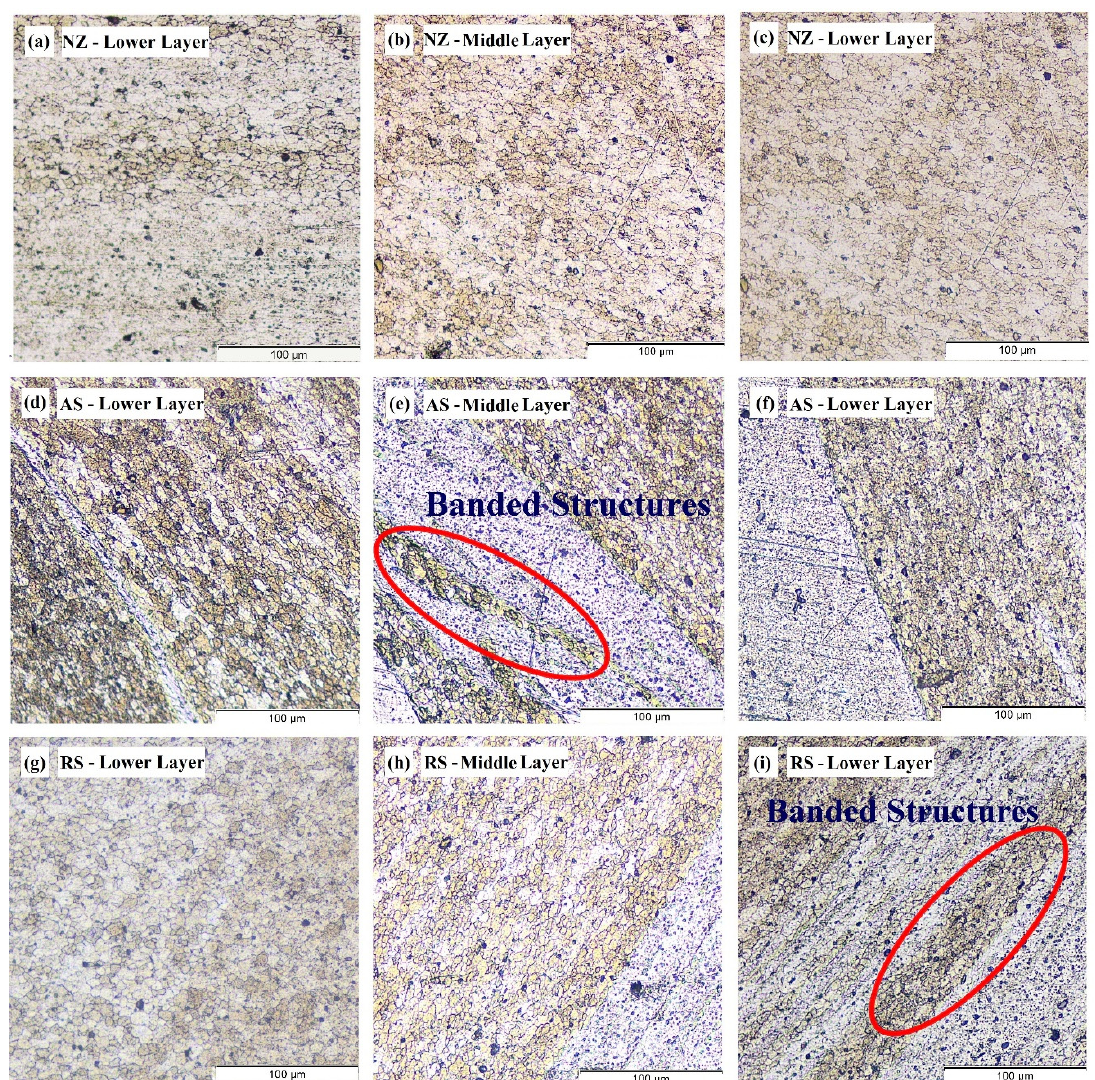
Figure 9. Microstructure of various areas in FSAM build ( a – c ) NZ in upper, middle, and lower layer, ( d–f ) AS in upper, middle, and lower layer, and ( g – i ) RS in upper, middle, and lower layer.